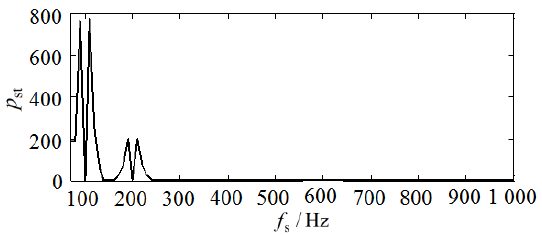
Figure 4. Curve of f s and p st